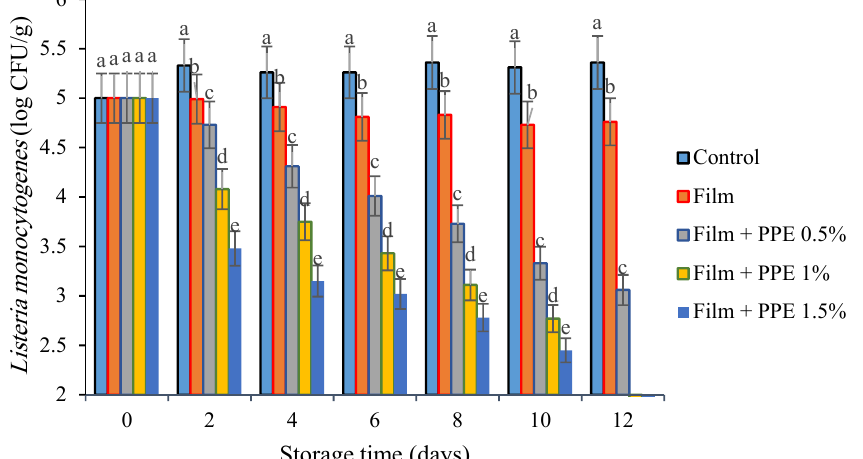
Fig. 5. Changes in Listeria monocytogenes of raw rainbow trout fillets packed in chitosan-ZnO films containing different concentrations of pomegranate peel extract (PPE) during refrigerated storage. Each number is the mean ± standard error taken from different experiments. a–e For each day, columns representing different bacterial population are labeled with different letters (P < 0.05)